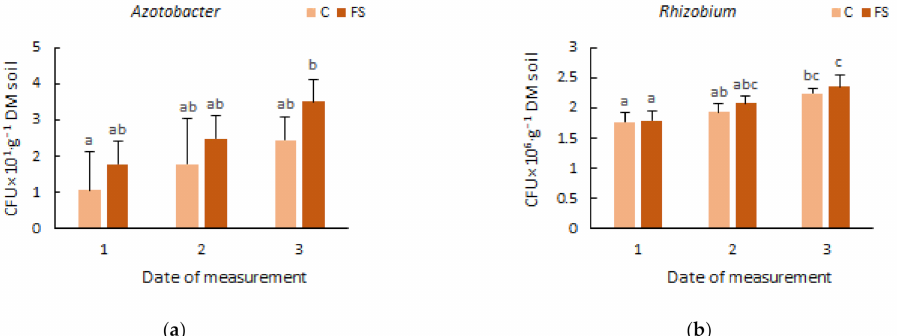
Figure 3. The number of ( a ) Azotobacter and ( b ) Rhizobium in soil after fertilisation. Different letters above the error bars (i.e., ± SD) indicate significant differences ( p < 0.05) between means (Tukey post-hoc test).